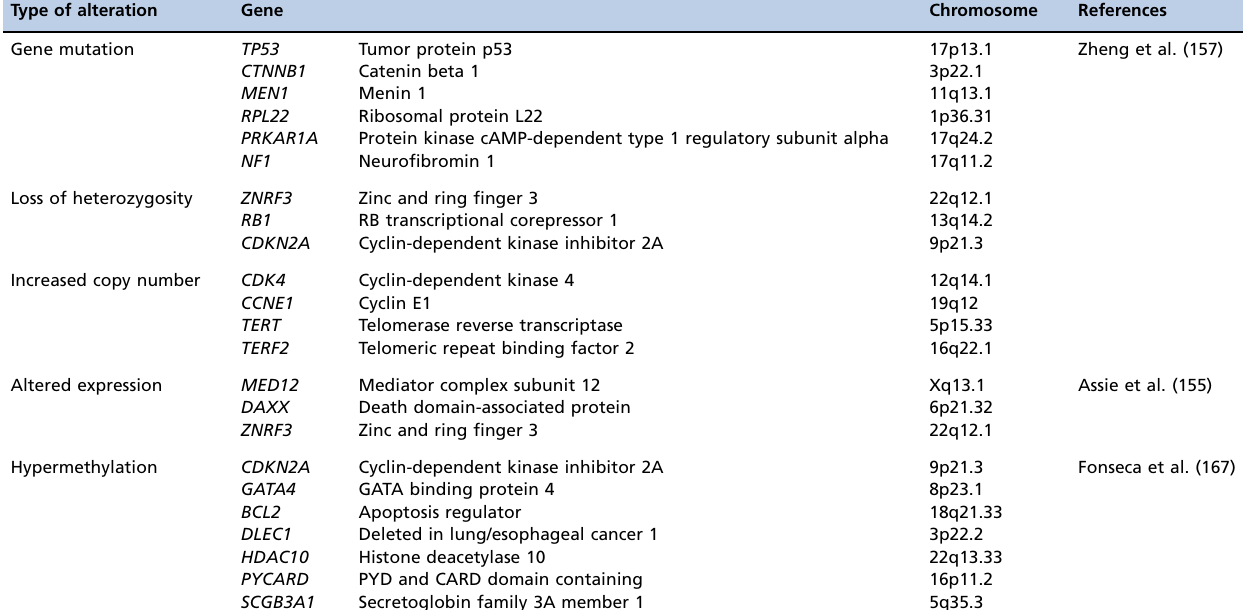
Table 2 - Summary of genetic alterations in comprehensive studies.